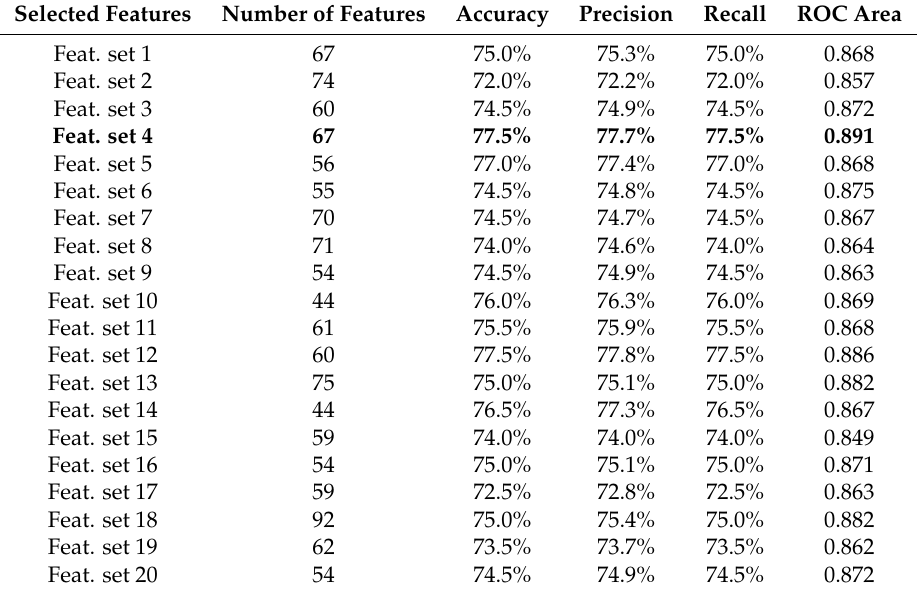
Table 7. Detection of benign or malignant using BGWO with wavelet features. Selected